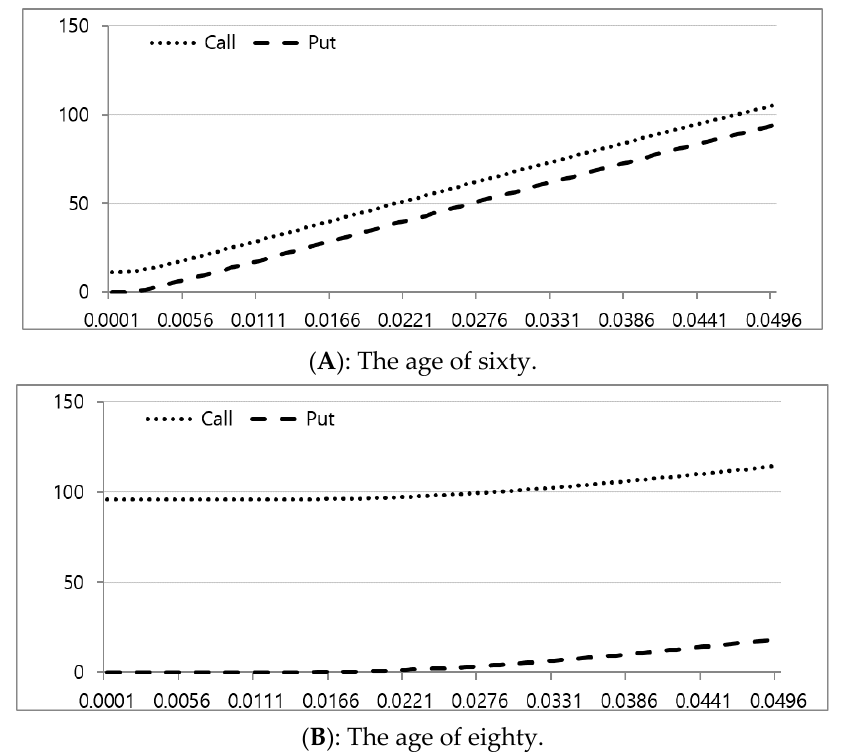
Figure 5. House price variation sensitivity analysis. This figure exhibits the estimated total option value by age group.